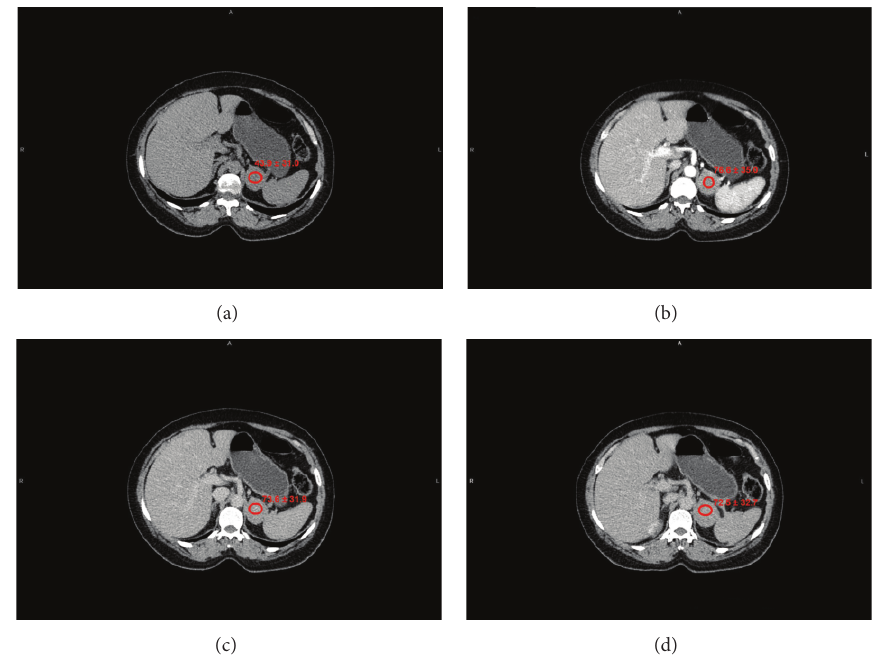
Figure 1: Pheochromocytoma. (a) Unenhanced attenuation values: 43, 9 ± 41 HU. (b) Portal-phase attenuation values: 76, 6 ± 35 HU. (c) 5 󸀠